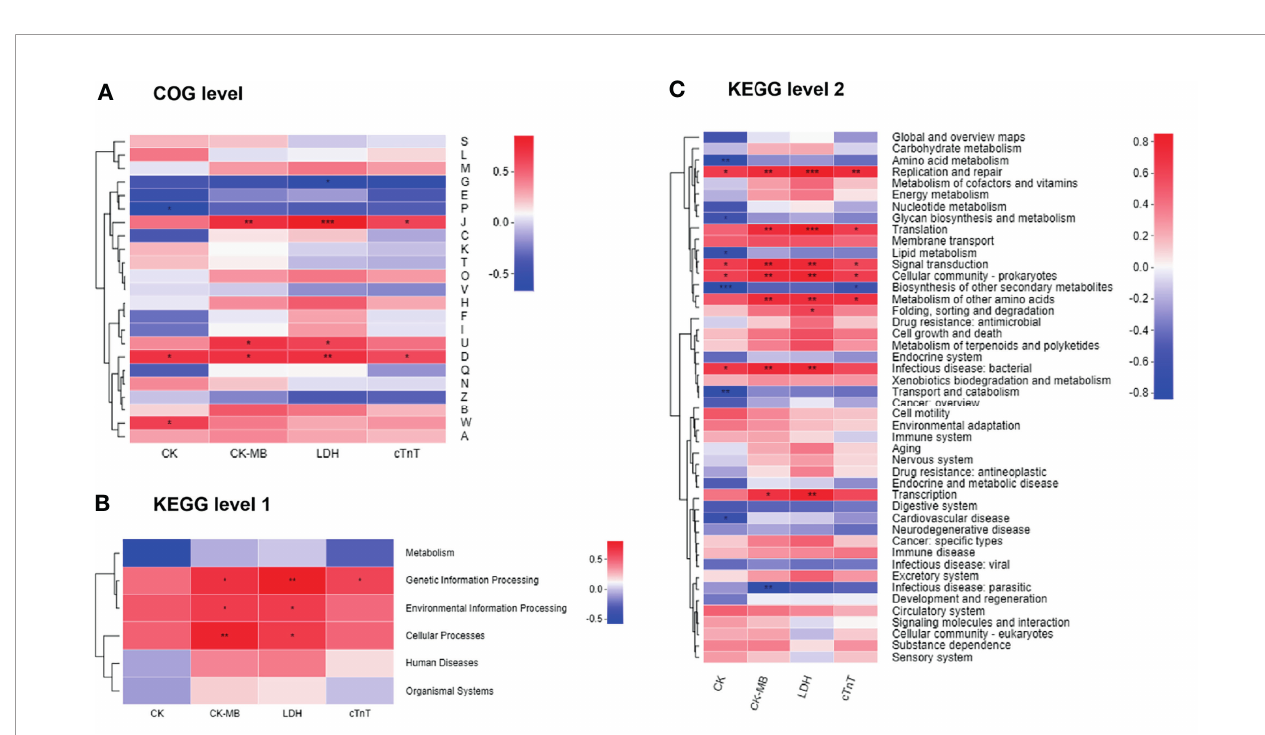
FIGURE 8 | Correlation heatmaps of functional pathways and clinical factors. (A) Heatmap at COG level. (B, C) Heatmaps at KEGG level. The x- and y-axes are clinical factors and functional terms. R in different colors is shown; the right side of the legend is the color range of different R values. CK, creatine kinase; CK-MB, creatine kinase-MB; LDH, lactic dehydrogenase; cTnT, cardiac troponin T; COG, Cluster of orthologous groups of proteins; KEGG, Kyoto Encyclopedia of Genes and Genomes. n = 6. * p < 0.05, ** p < 0.01, *** p < 0.001.